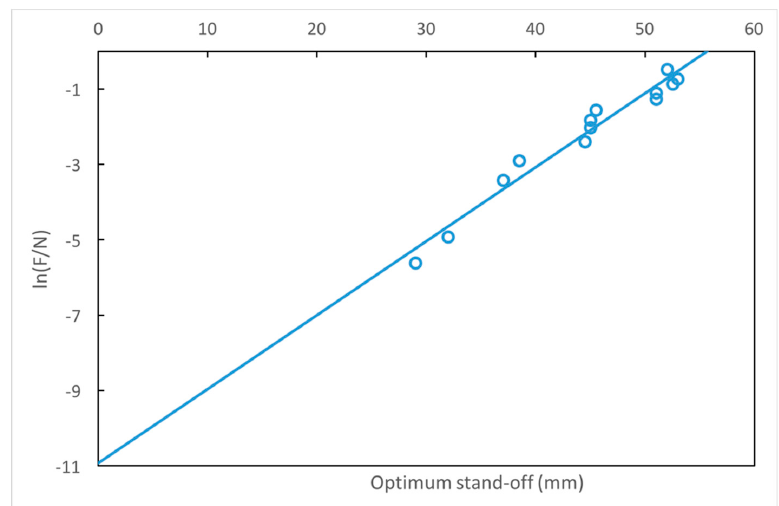
Figure 7. Illustration of the relation between the axicon lens optimum stand-off δ and the ratio of F/N. The value of δ estimated by linear regression is indicated to obtain the highest lateral resolution for different lens angles.